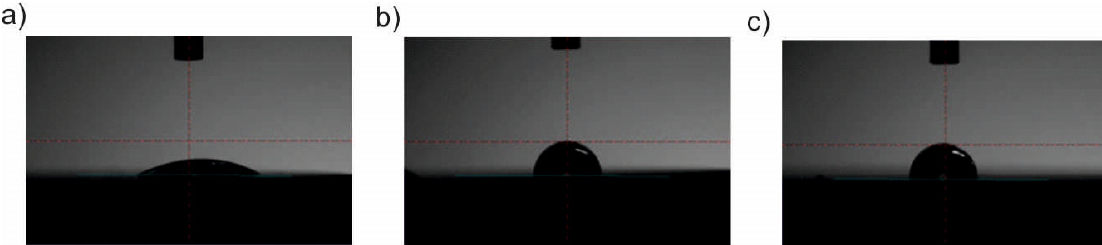
Figure 19. Examples of sessile drops applied to an electropolished sample: ( a ) initial state; ( b ) 500_200 °C; ( c ) 1500_200 °C.